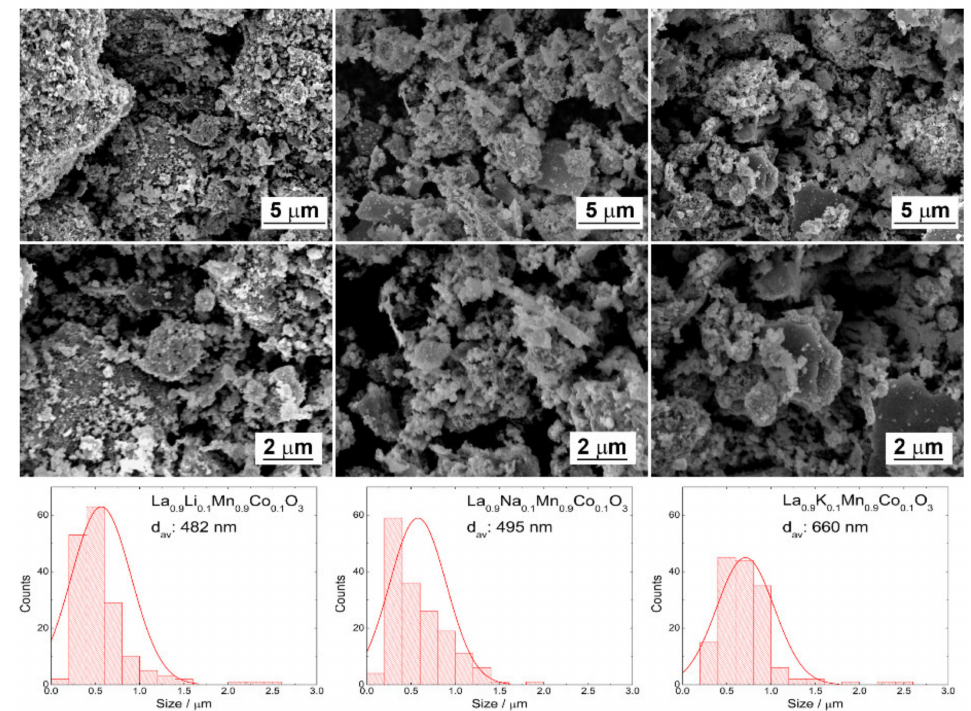
Figure 2. SEM images and particle size distribution of La 0.9 A 0.1 Mn 0.9 Co 0.1 O 3 (A: Li, Na, K) powders.